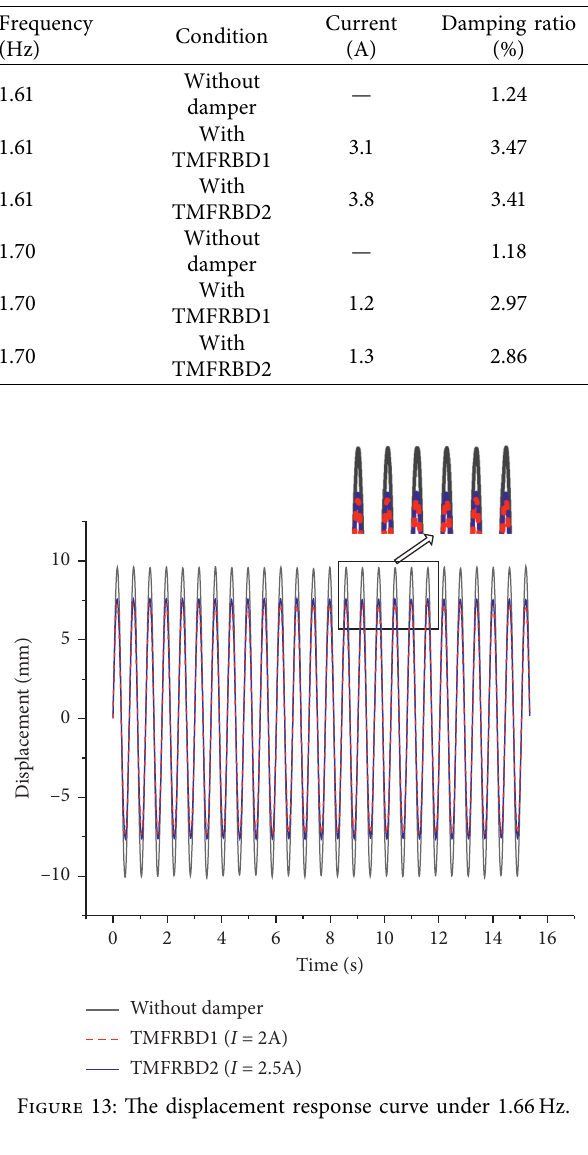
Table 2: The test results of harmonic forced